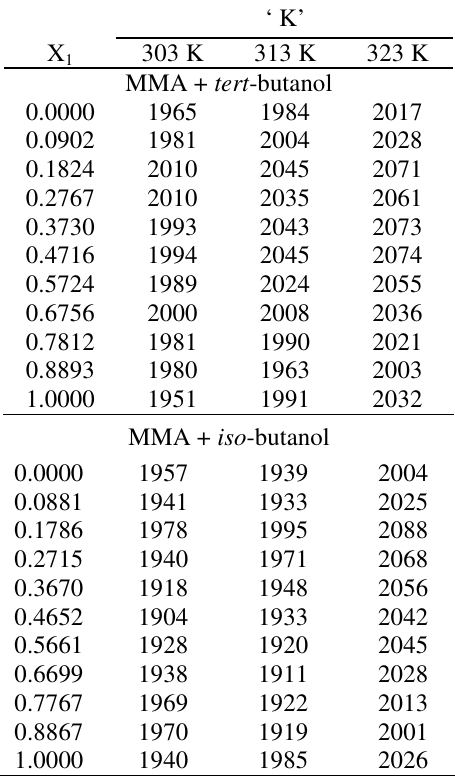
X = K for binary mixtures at three different V i f